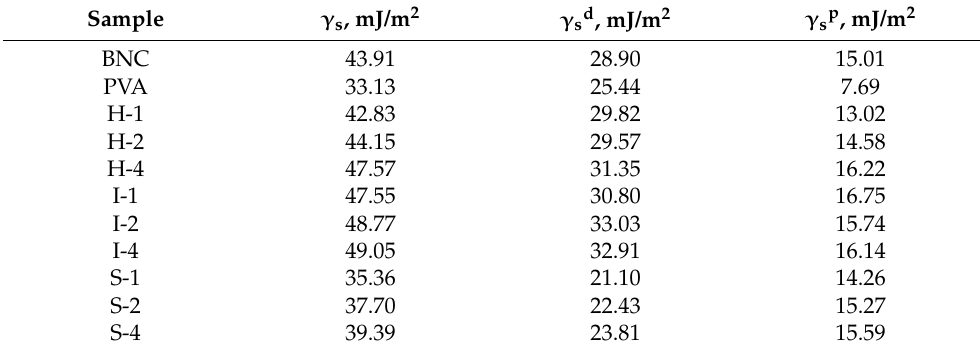
Table 5. Surface free energy ( γ s ) and its polar ( γ p ) and dispersion ( γ d ) components of the BNC, PVA, and BNC/PVA